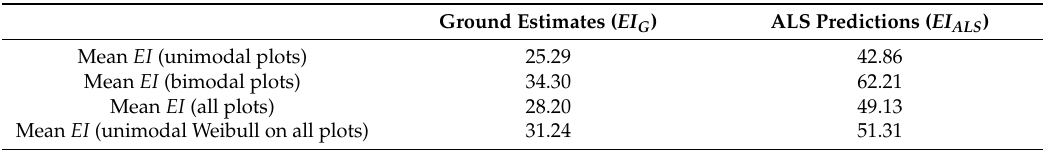
Table 7. Measured ( EI G ) and predicted ( EI ALS ) values on sample plots, showing differences in unimodal and bimodal